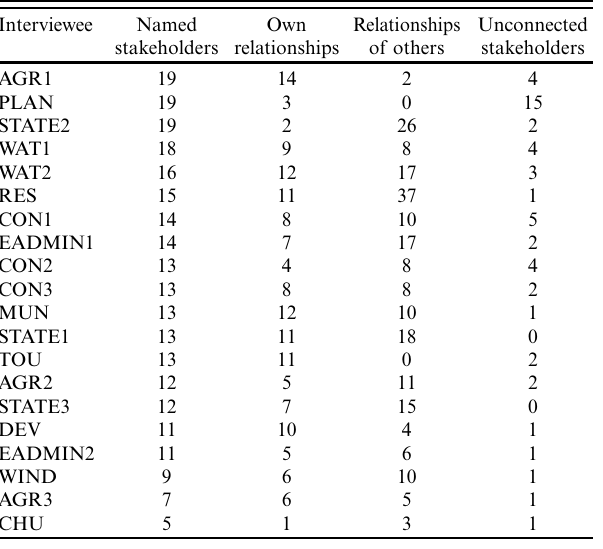
Table 2. Quantitative representation of stakeholders and relationships named during